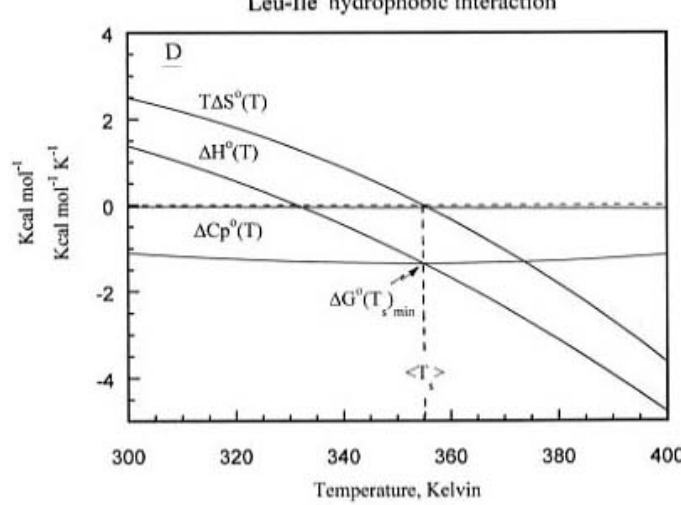
In the thermodynamic methods based on our development of Planck-Benzinger methodology[1,2,3,4,5,6,7,8,9,10,11,12,13,14,15], computed values must be in agreement with experimentally obtained K values [and therefore with values of ∆ Gº(T) of reaction] of eq biological systems over a temperature range of 273 − 343 K.